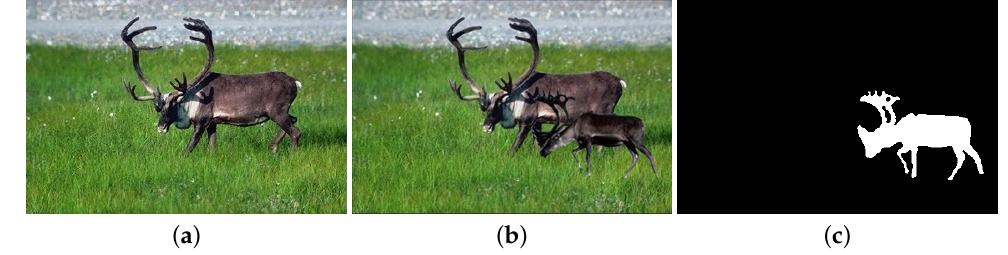
Figure 1. The three images represent the host image, the forgery image and the ground-truth. ( a ) Host image. ( b ) Forgery image. ( c )